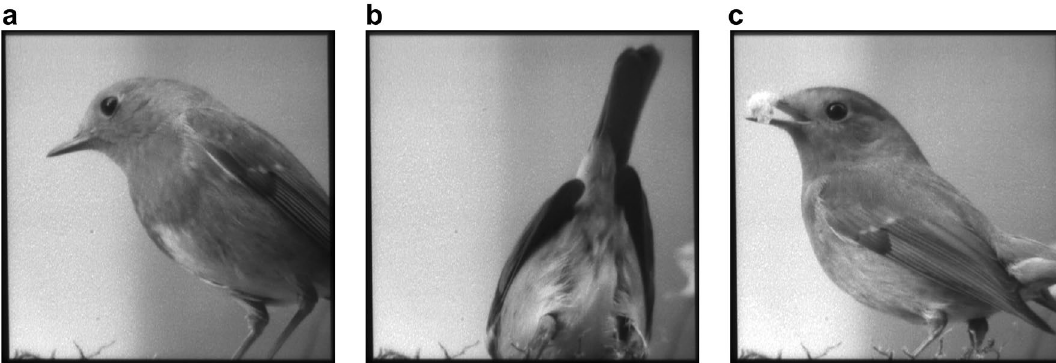
Figure 6. Frames of an experimentally reconstructed video (350 × 350 pixels). ( a – c ) The lively scene was reconstructed at 39 Hz with a line integration time of τ = 8T T and demonstrates the capability of the HALM system for laser video projection. The video was recorded with different detector integration times and frame rates (see visualizations 1–5 in the supplementary